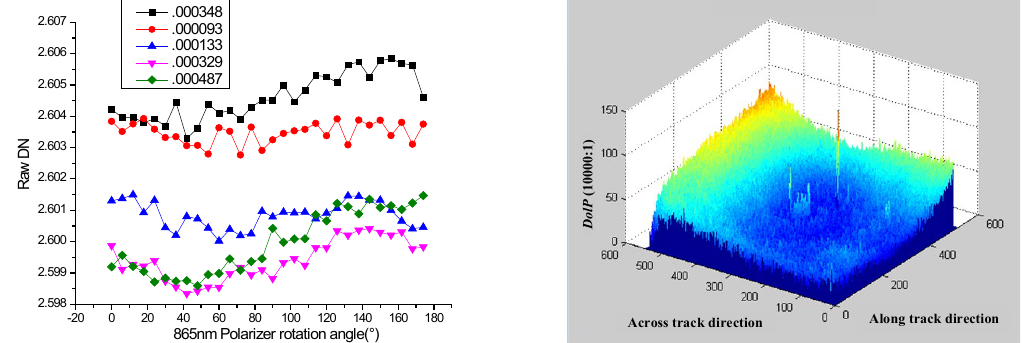
Figure 11. The polarization produced by LEAIS 865nm in the full FOV (left) and polarimetric calibration accuracy validation results of SDPC 865nm channel tested by LEAIS